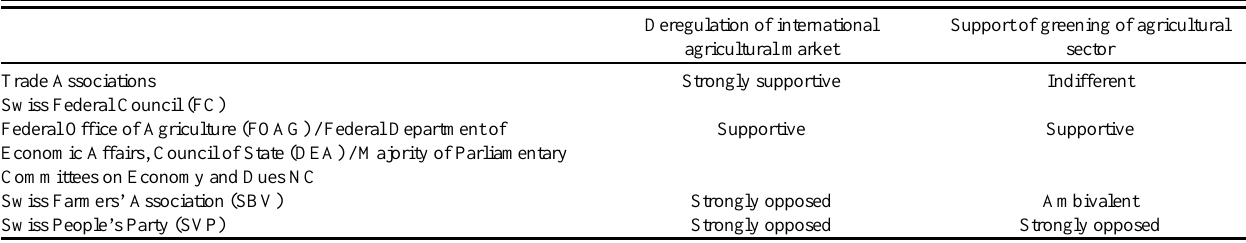
Table 5 . Policy positions of core actors in the Swiss agricultural policy